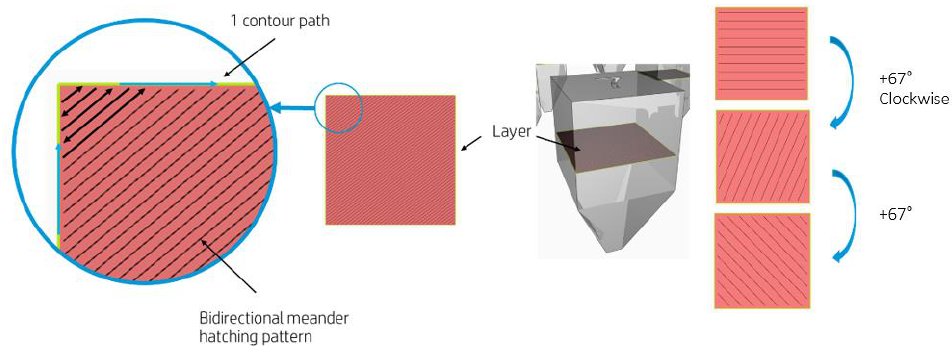
Figure 2. Manufacturing path strategy: layer path and part path.